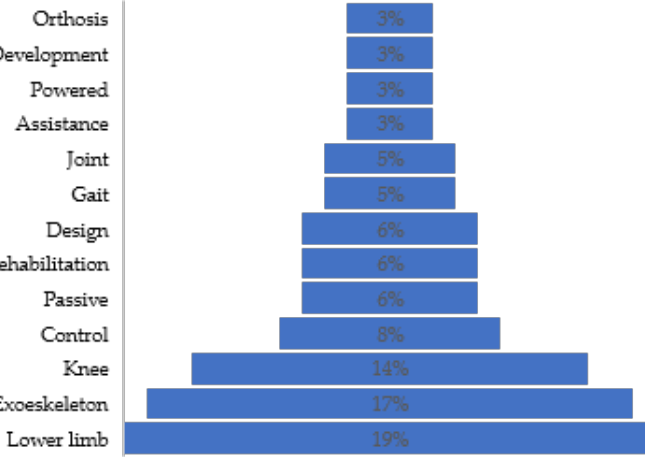
Figure 9. Main keywords found in scientific documents.